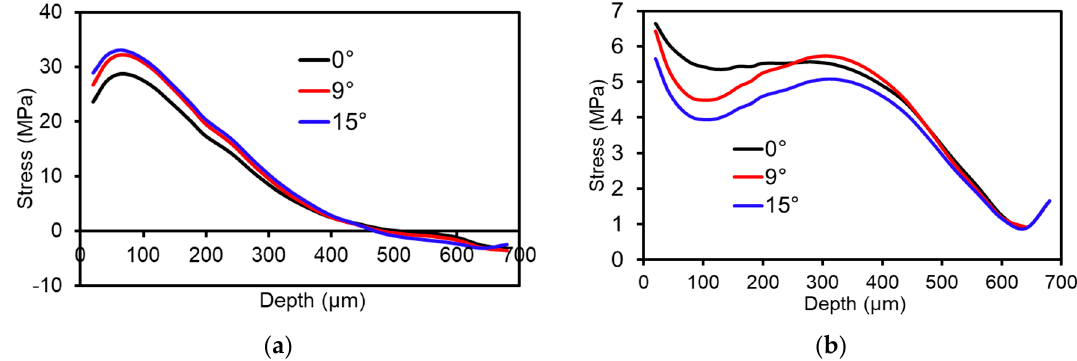
Figure 11. Effect of the orientation between the fiber and strain gauge on the residual stresses. The strain gauge has been applied with an offset angle of 0, 9 and 15 degrees, respectively. ( a ) σ x and ( b ) σ y , where the combination 1 of strain gauge grids in Figure 2b is employed. See text for details.